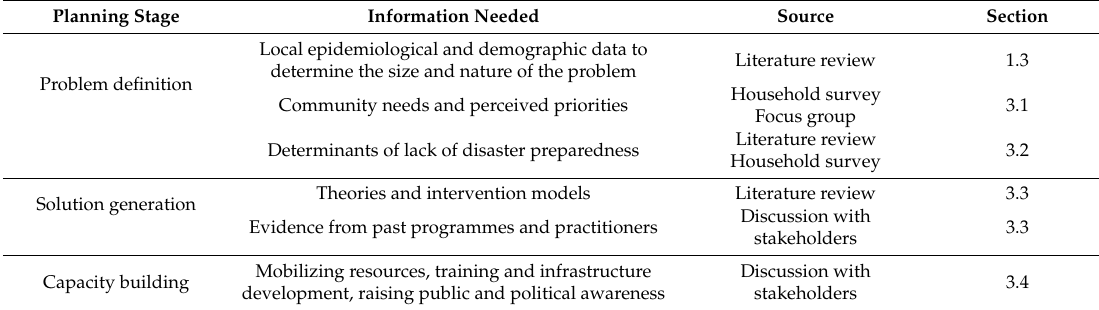
Table 1. Summary of information needed and sources for each planning